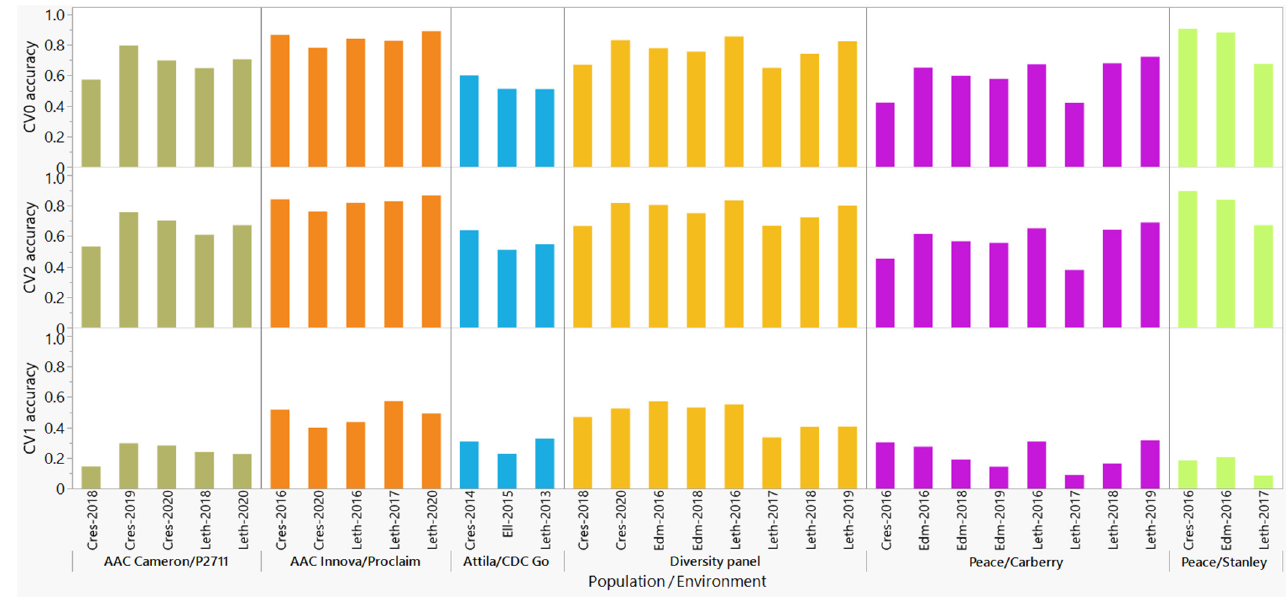
Figure 4. Comparisons of prediction accuracies of stripe rust resistance in six spring wheat populations evaluated at three to eight environments using the M3 model and three random cross-validation scenarios (CV0, CV1, and CV2). In each population, CV1, CV2, and CV0 represent predicting the performance of a subset of 25% of newly developed lines that have not been tested in any environment, a subset of 25% of lines tested in some but not other environments (sparse testing), and all lines tested in some environments but missing in others, respectively. Each environment starts with a prefix representing the experimental site (Cres: Creston, Leth: Lethbridge, Edm: Edmonton, Ell: Ellerslie) followed by the year of the trial.